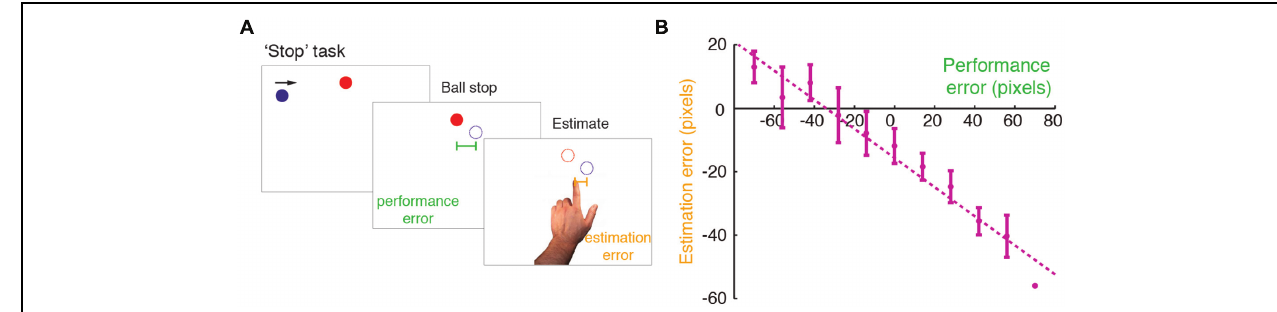
FIGURE 1 | Modified ‘Stop’ task performed in the study. (A) An illustration of the modified Self Stop task (Wolpe et al., 2014). Subjects watched a blue ball that repeatedly swept horizontally across the screen in a rightward motion. They were asked to press a key with their right hand, so as to stop the ball when it was vertically aligned with a red target. Following the stopping event, subjects estimated where they had stopped the ball, by pointing on the screen with their left index finger. For each trial, we examined their performance error (difference between the actual stopping position and the target position) and estimation error (difference between the pointing position and the actual stopping position). (B) Estimation errors plotted against performance errors for a typical subject (here a control subject). The dashed line indicates a linear regression fit, and the error bars indicate SD. Note the leftward shift in the intercept of the regression line, which was accounted for in the Bayesian model